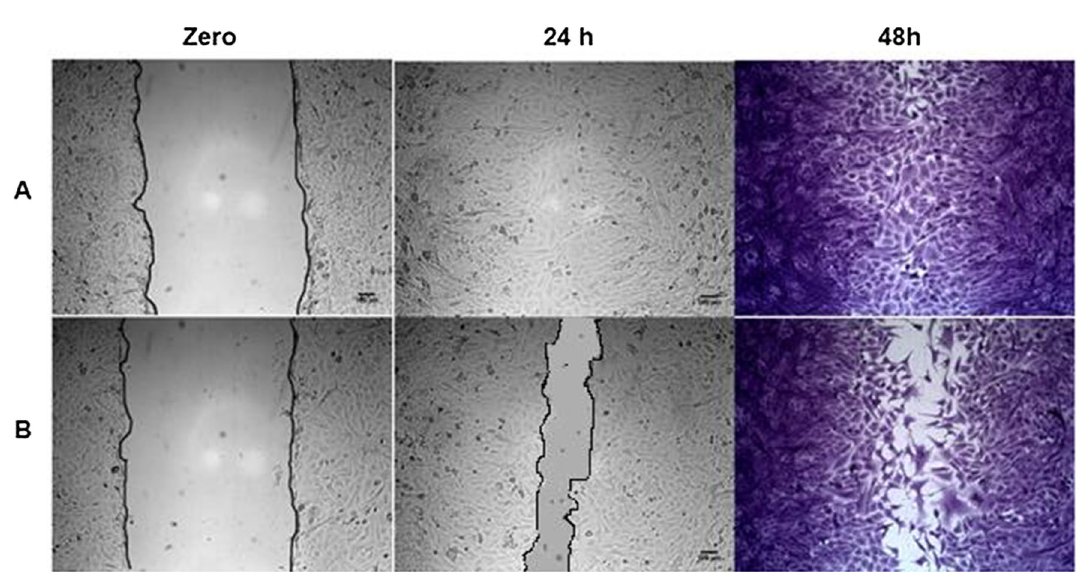
Fig. 5 The wound healing assay in MCF-7 cells, A Untreated cells, B cells treated with bithiophene-fluorobenzamidine (BFB) at 1.06 µM (IC ). *Significant (p < 0.05) compared to untreated cells from two independent 50